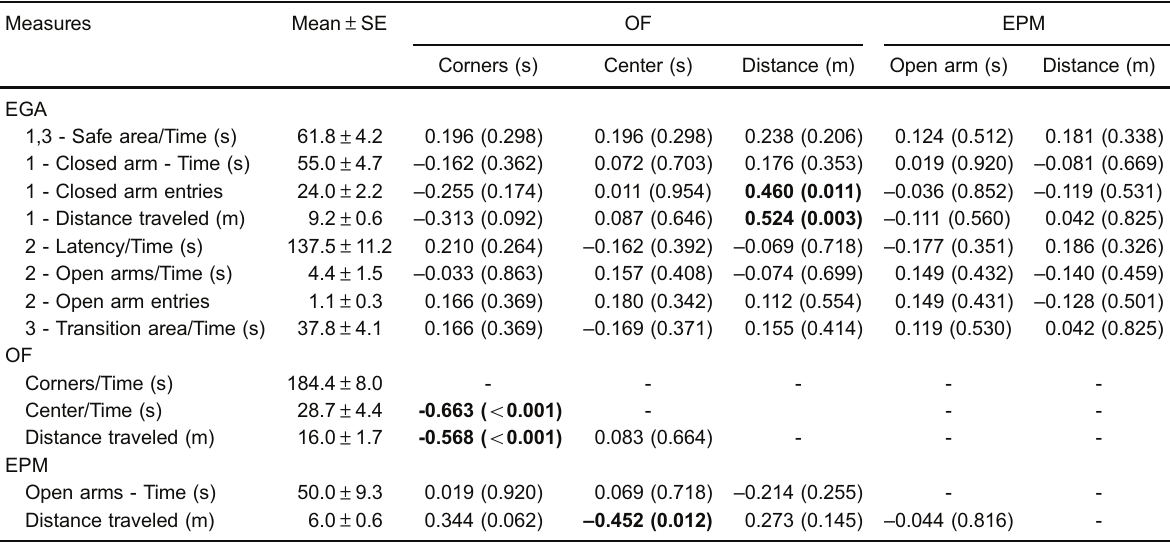
Table 5. Correlation indices between open- fi eld (OF) and elevated plus-maze (EPM) measures of ambulation and anxiety with elevated gradient of aversion (EGA) measures.